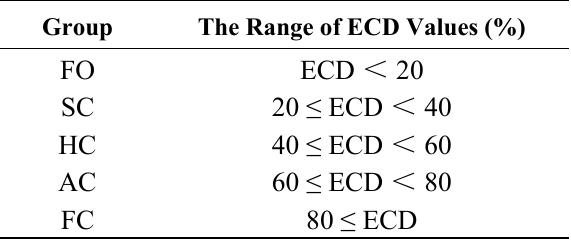
Table 1. Summary of the ECD groups’ detailed information.